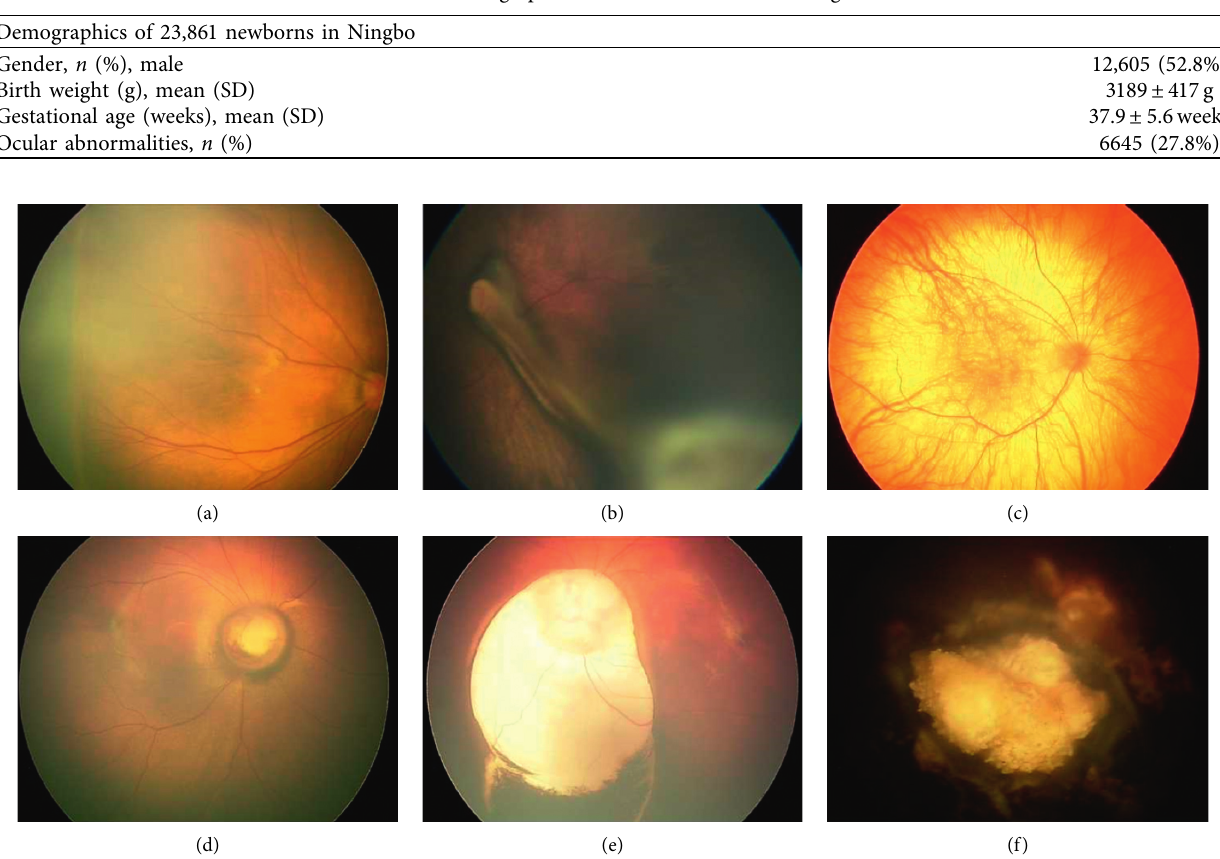
Table 1: Demographics of 23,861 newborns in